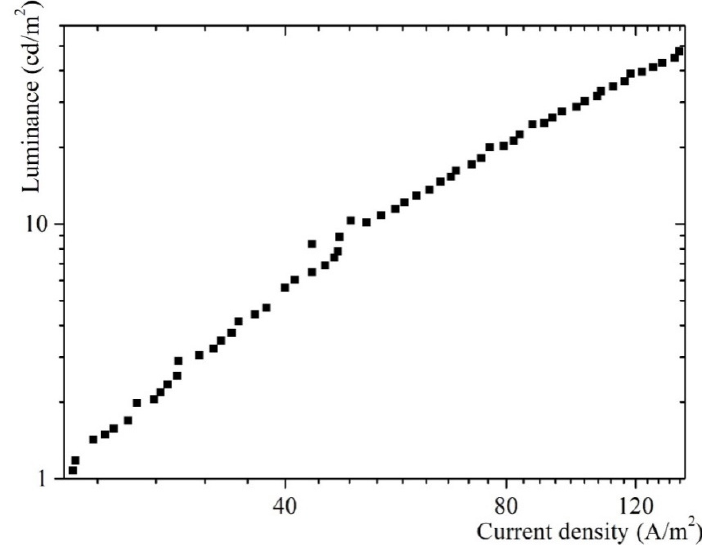
Figure 6. Luminance versus current density characteristic of the device realized with the 10 wt.% C1-PVK blend.